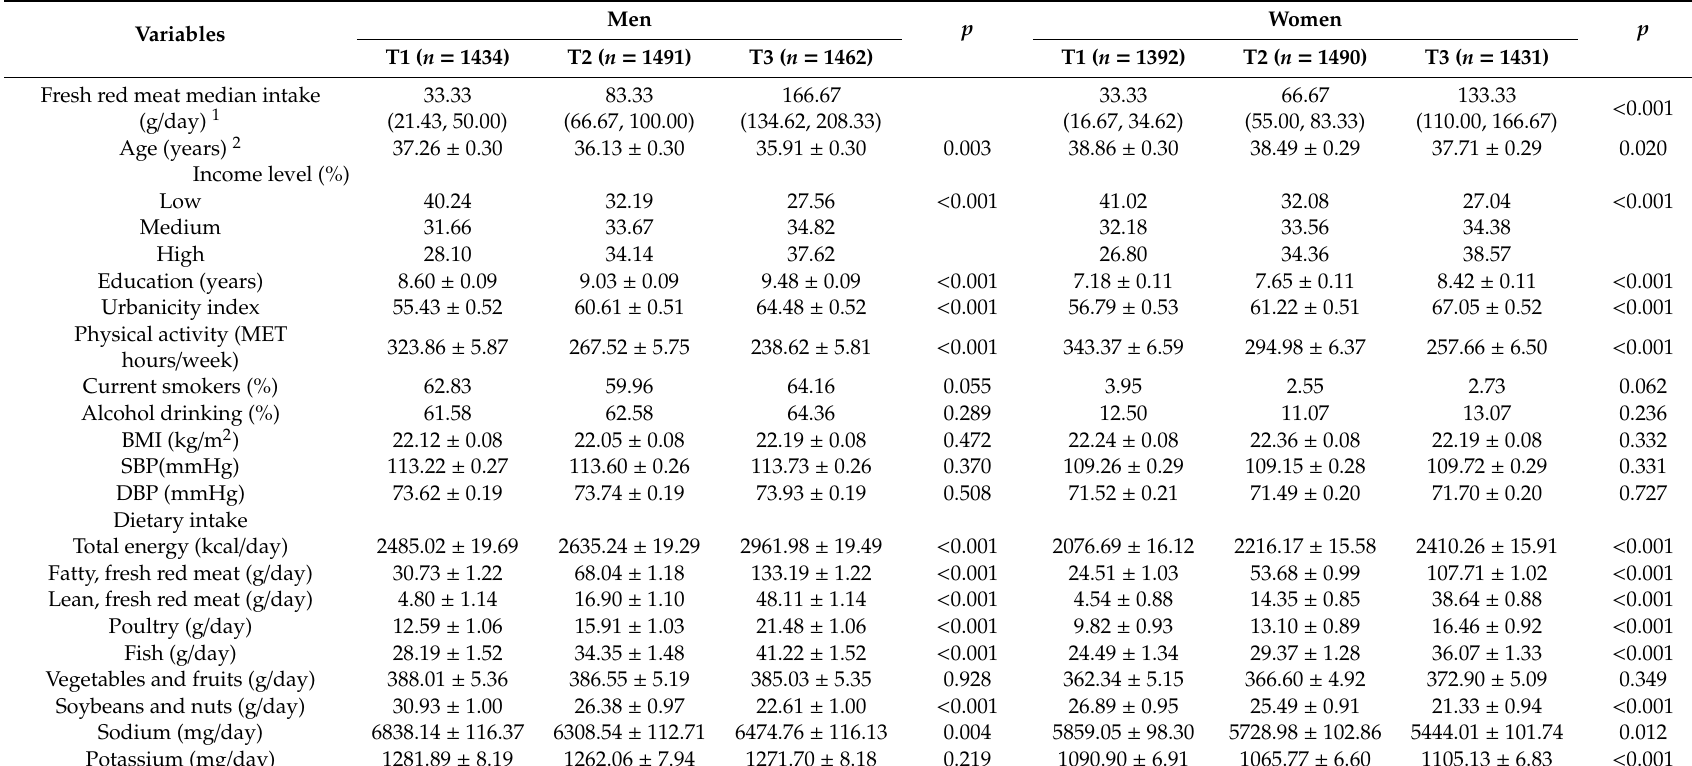
Table 1. Baseline characteristics of participants according to three levels of total fresh red meat consumption by gender,